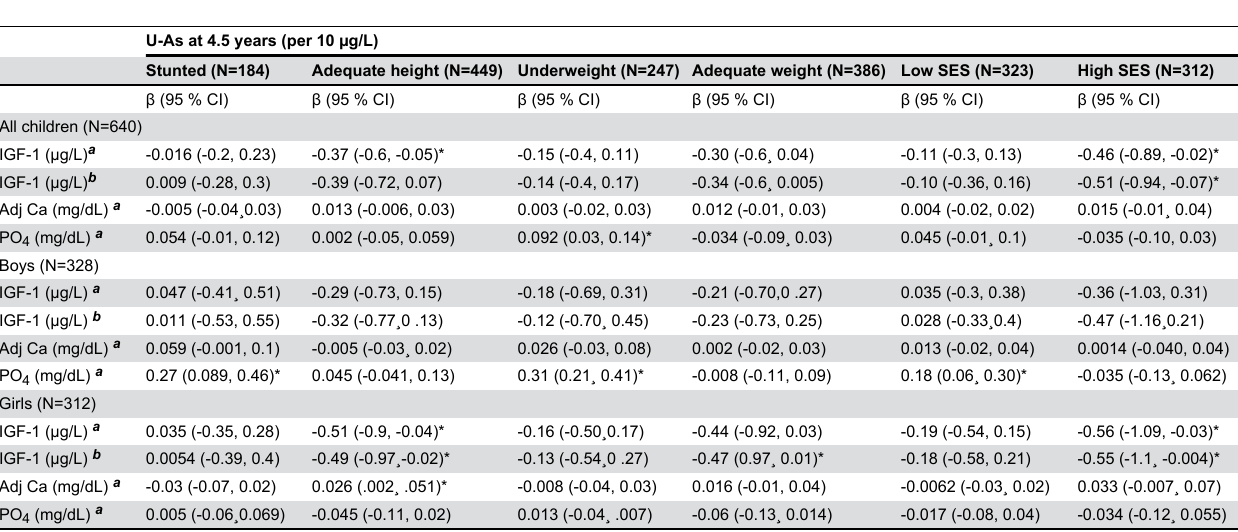
Table 5. Linear regression analysis of associations between concurrent arsenic exposure and plasma growth biomarkers in 4.5 yr old children in relation to growth retardation and socioeconomic status.